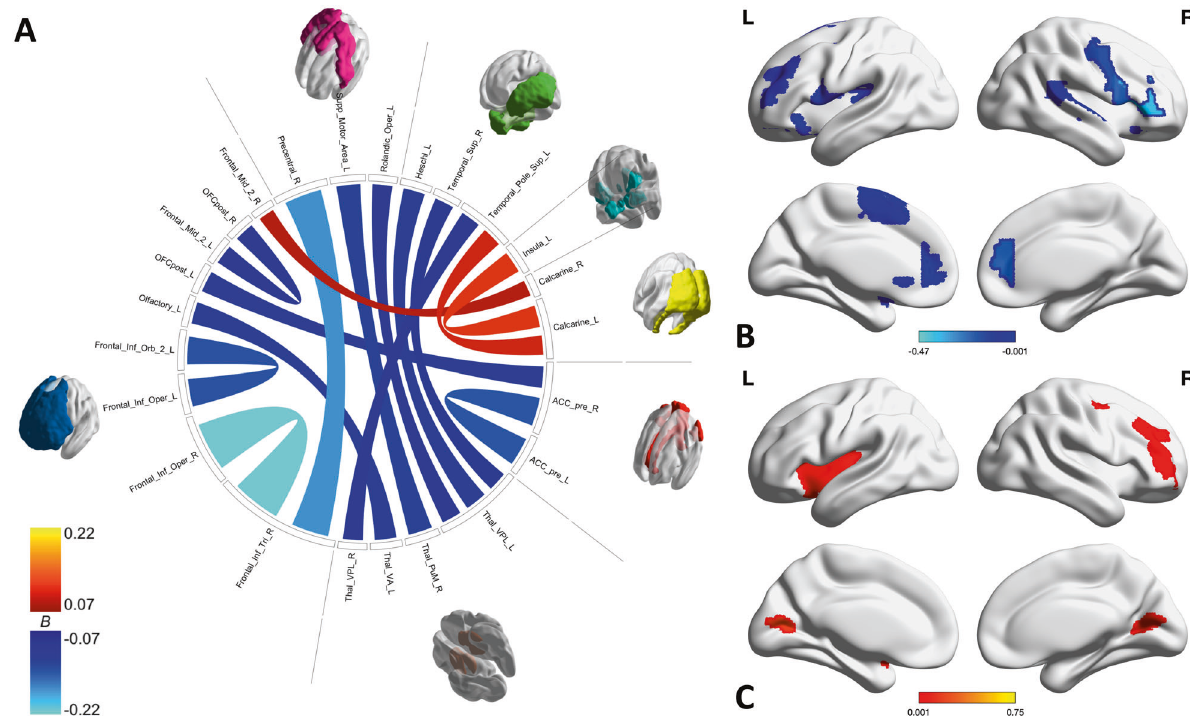
Fig. 2 Within ASN connectivities and regions associated with worry. A Chord diagram shows individual connections identi fi ed by HC with both weight and color indicating the strength of the association with worry severity. B , C Brain maps show the sum of the negative ( B ) and positive ( C ) associations with worry for each region. Negative associations with worry dominate, especially in the ACC, thalamus, OFC, and other inferior frontal regions.